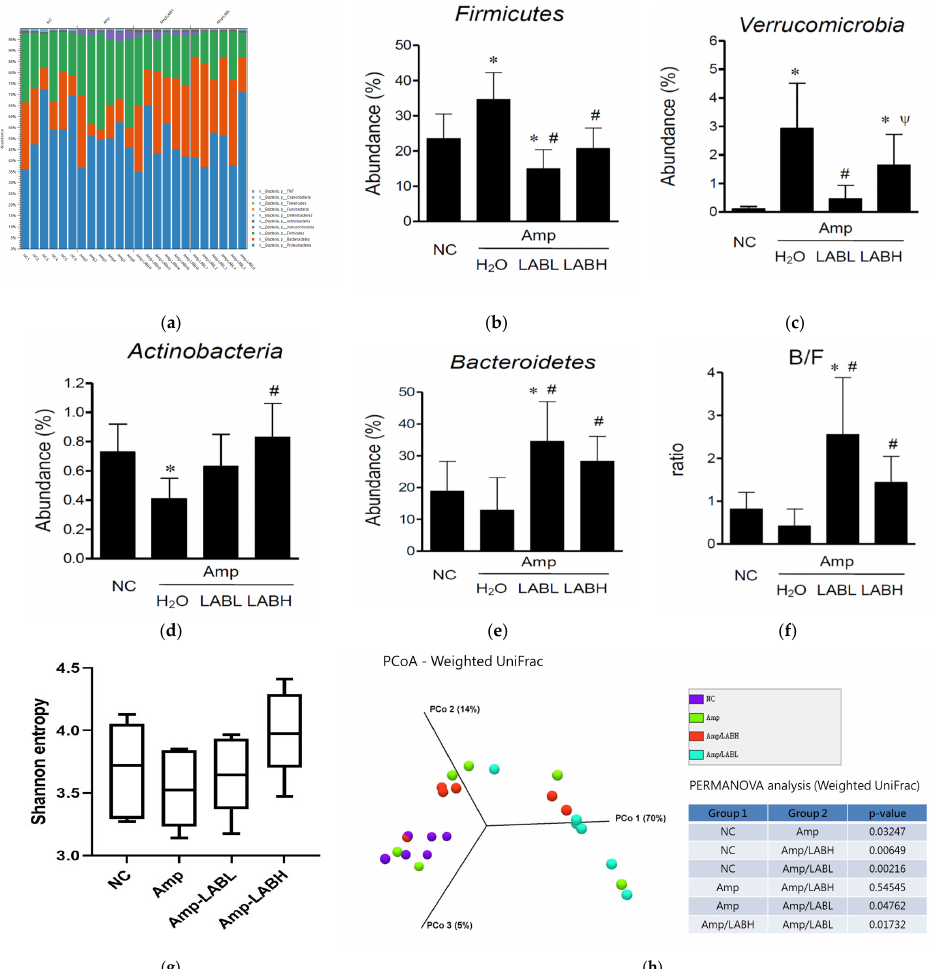
Figure 3. Effect of Lactobacillus spp. on gut microbiota composition at the phylum level and diversity and taxonomic profiling in C57BL/6J mice. C57BL/6J mice ( n = 6/group) were grouped into the NC and Amp groups. The groups given the three − strain combination were fed a dose of 1.6 × 10 8 CFU/mouse (LABL) or 4.8 × 10 8 CFU/mouse (LABH) from the 3rd day until the 7th day. All groups were analyzed for 16S ribosomal RNA V3 − V4 gene expression in the ileum on the 12th day. ( a ) Phylogenetic cladogram from the LEfSe analysis, ( b ) Firmicutes spp., ( c ) Verruocrobia spp., ( d ) Actinobacteria spp., ( e ) Bacteroidetes spp. ( f ) B/F ratio communities in the control and Amp groups. ( g ) α− diversity of intestinal microbial communities. ( h ) β− diversity of intestinal microbial communities. *, compared with NC group, p < 0.05; #, compared with Amp group, p < 0.05, Ψ , compared with LABL group, p < 0.05.